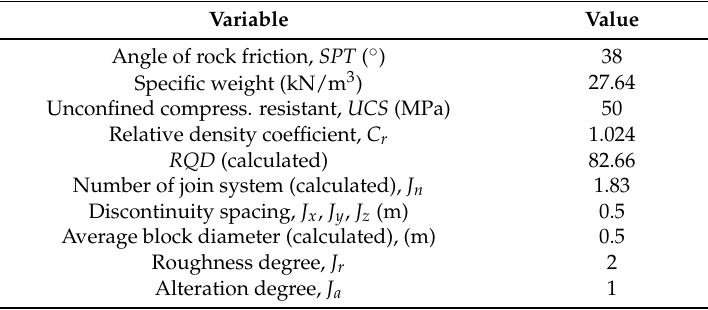
Table 5. Semi-empirical methodology. Input and calculated